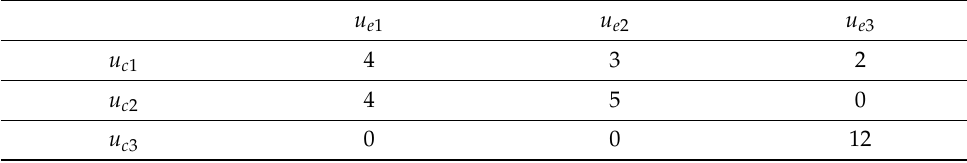
Table 3. The cost matrix δ cost to be